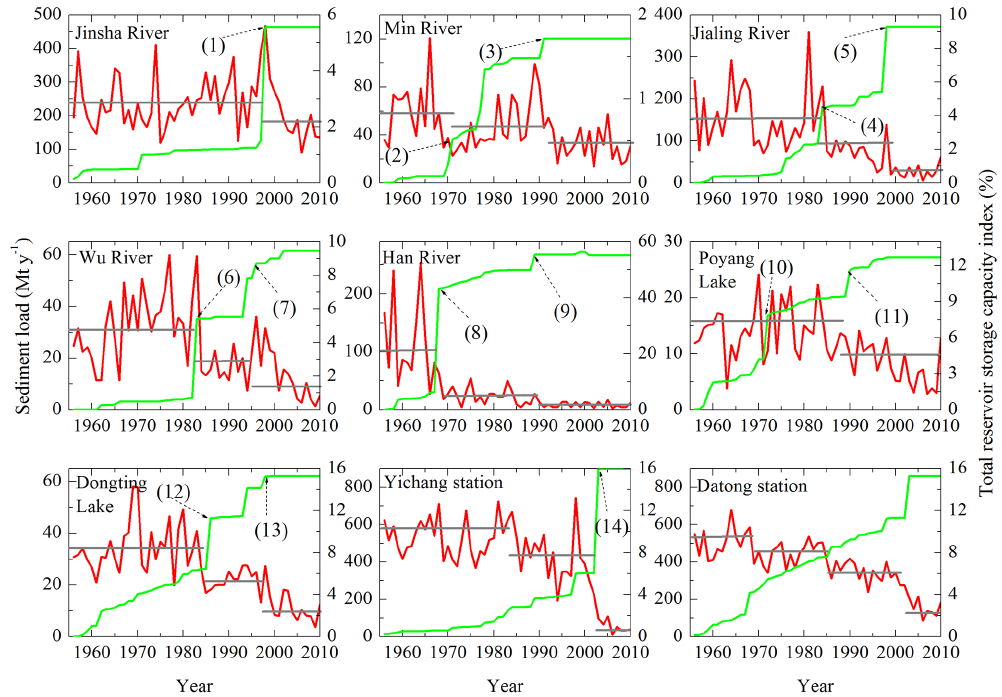
Figure 2. Relationship between the reduction in sediment load (red line) and the total reservoir storage capacity index (green line) in the tributaries and the main stream. Numeric symbols represent reservoirs listed in Fig. 1.